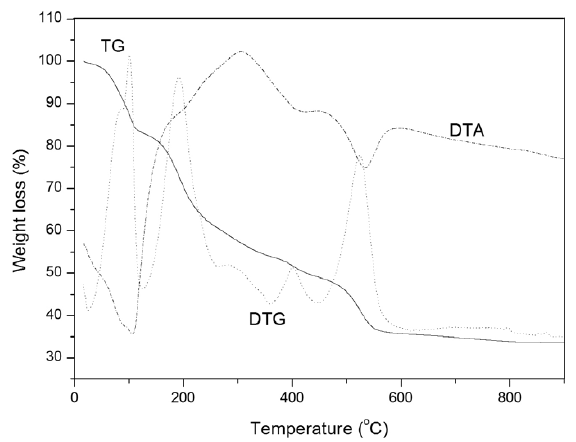
Figure 1 - Location of the study area on Areuá Island, Curuçá, State of Pará, Brazilian Amazon.